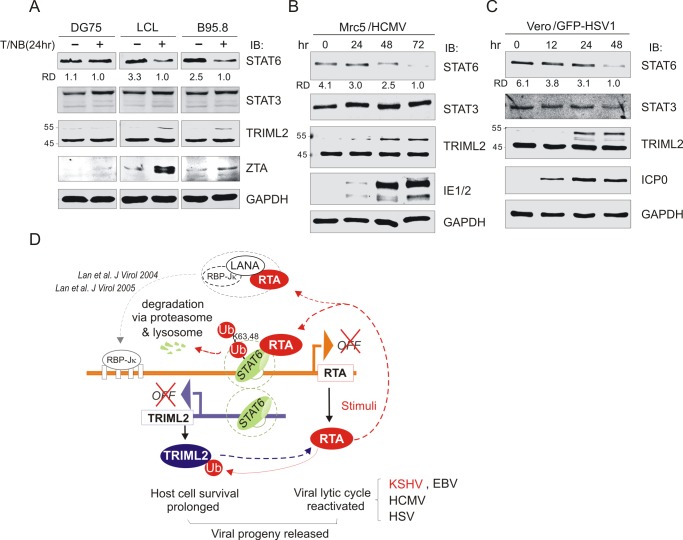
Low expression of STAT6 and high TRIML2 ubiquitylation were present during EBV, HCMV, and HSV1 lytic replication.(A) EBV reactivation led to inhibition of STAT6 expression and increased monoubiquinated TRIML2. Whole cell lysates from EBV-positive (LCL and B95.8) and negative (DG75) B lymphoma cells with TPA and sodium butyrate treatment for 24 h, were individually subjected to immunoblotting as indicated in the figure. (B) and (C) De novo infection of HCMV and HSV1 led to inhibition of STAT6 expression and increased monoubiquinated TRIML2 in early lytic replication. Mrc-5 (human fetal lung fibroblast cells) and Vero (monkey kidney epithelial cells) were individually infected with HCMV and HSV1 at an MOI of 3 and 0.1 as described in material and method. Cells were harvested at different time points and lysed for immunoblotting as indicated in the figure. RD, relative density. (D) Proposed model of RTA-induced degradation of STAT6 upon KSHV reactivation. During reactivation of KSHV latently-infected cells by stimuli like TPA and sodium butyrate, KSHV encoded RTA not only blocks formation of LANA-RBP-Jκ complex (Lan et al, J Virol 2004, 2005), but also induces K48- and K63-linked ubiquitylation of STAT6 for degradation via proteasome and lysosome. The interaction between STAT6 and RTA not only leads to STAT6 degradation but also increase TRIML2 expression and ubiquitylation, which in turn prolongs host cell survival in lytic replication and enhances RTA expression, and facilitates viral progeny production. Similar effects are observed in other human herpesviruses including EBV, HCMV and HSV1 as indicated.